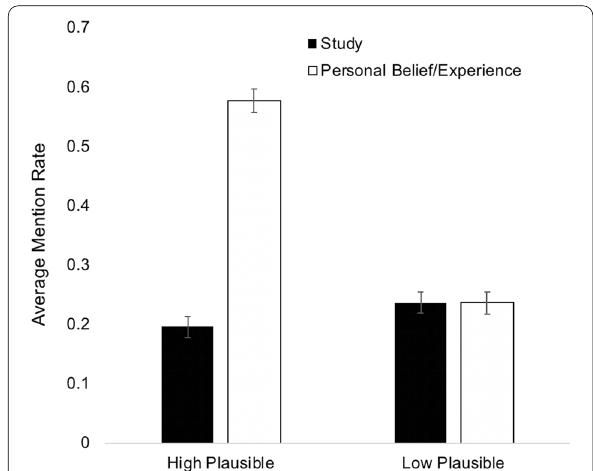
Fig. 7 Rates of mentioning the study and personal experiences/ beliefs for explanations for incorporate likelihood ratings as a function of intervention plausibility (high/low) for Experiment 2. Error bars represent within-subjects standard error of the mean (Cousineau,